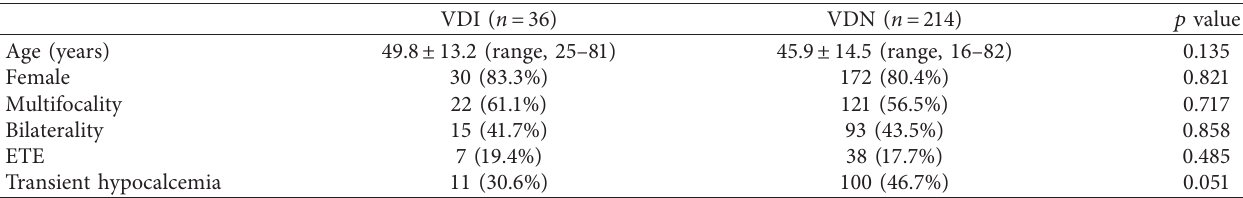
Table 7: Subgroup analysis between vitamin D3 injection (VDI) and vitamin D3 noninjection (VDN) groups in postoperative PTH range from 10 to 15 pg/mL.